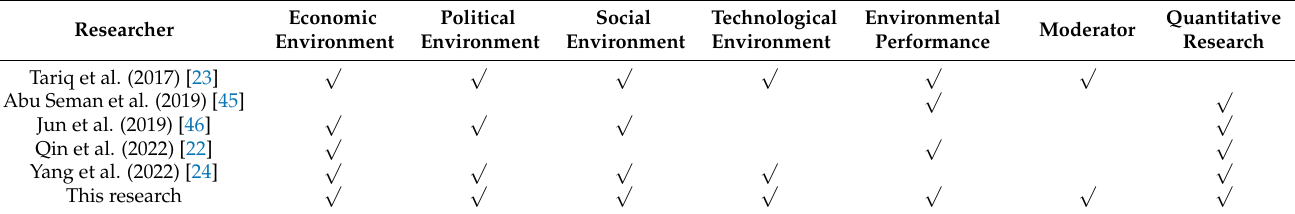
Figure 1. A theoretical model of enterprise green innovation behavior. Note: Summary by authors according to [26,42]. Table 1. Research